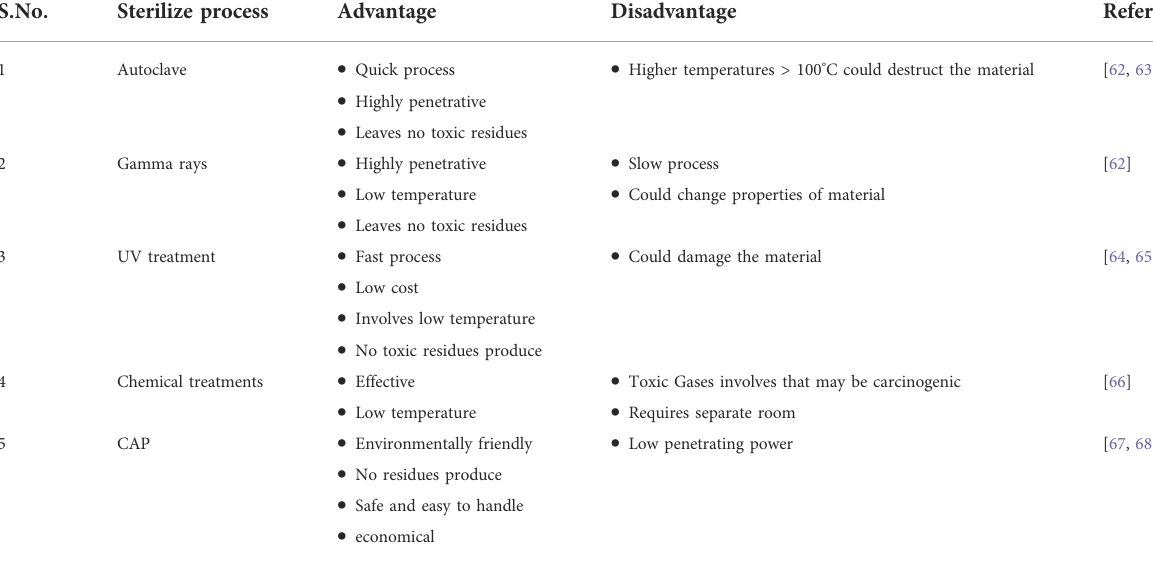
TABLE 2 Existing sterilization process and its advantage and disadvantages.